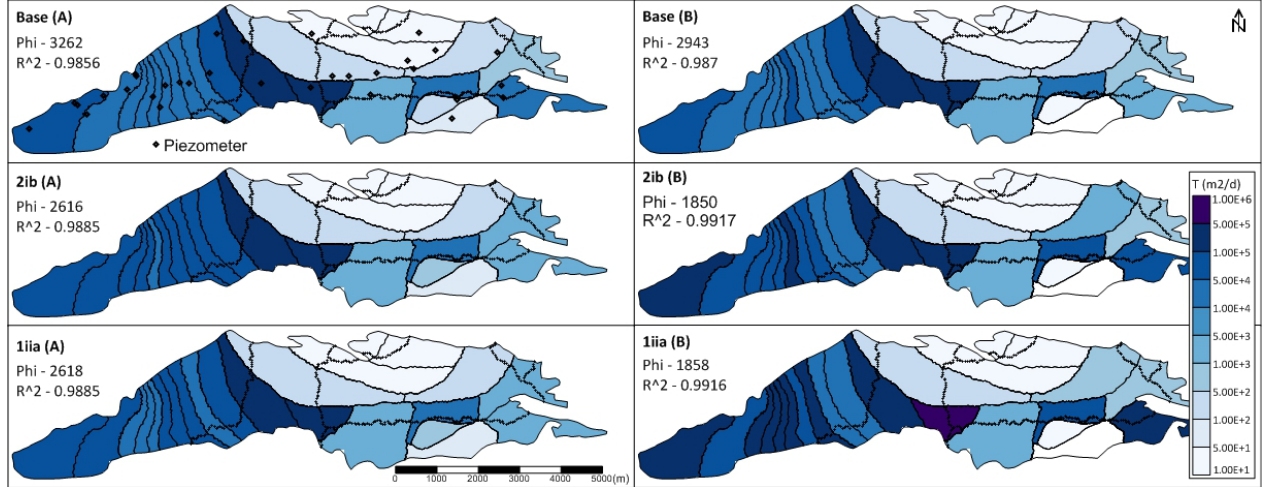
Fig. 3. Spatial distribution of T estimated by inverse modelling considering areal recharge rates from Vieira and Monteiro (2003) and BALSEQ MOD (Oliveira et al., 2008) for three scenarios of stream recharge (see Table 1 for detailed scenario descriptions) and their respective calibration statistics Phi (sum of squared residuals) and R 2 (coefficient of determination between measured and simulated head).